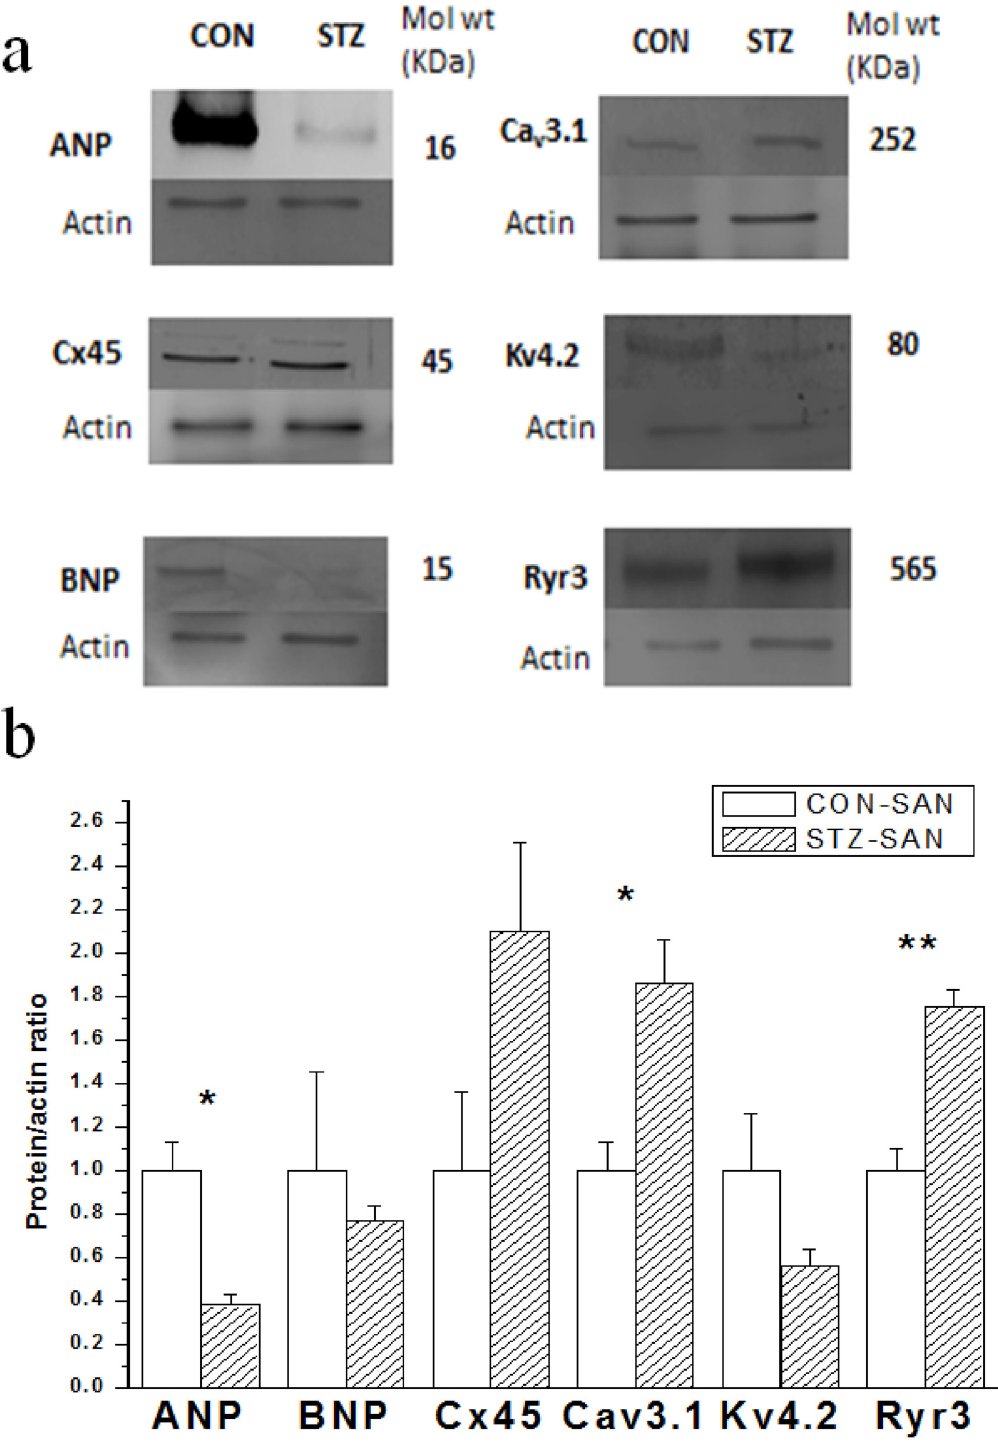
Fig 11. Typical Western blots comparing expression of various proteins from STZ and control SAN are shown in Fig 11a. The blots shown are representative of 3 individual samples from STZ and control rats each containing SANs from 2 hearts. The Protein/actin ratio for the different proteins are shown in Fig 11b. Data are mean ± SEM, n = 3 samples from STZ and control rat each containing SANs from 2 hearts. * P < 0.05, ** P <